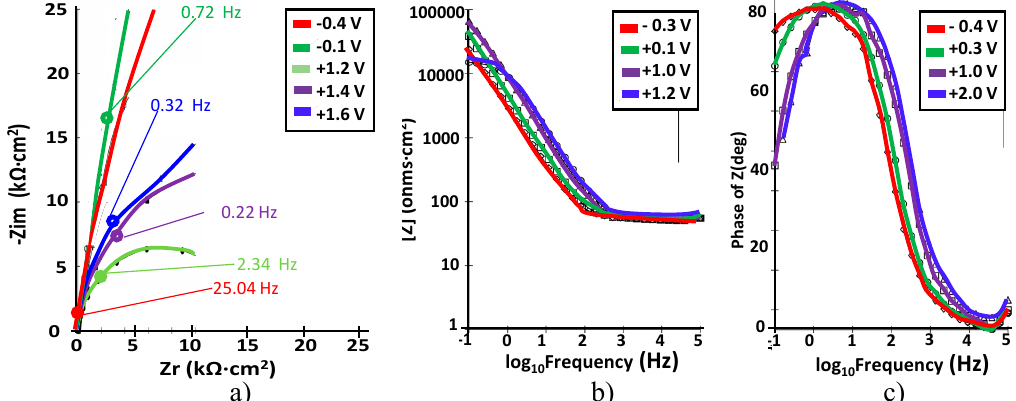
Figure 8. ( a ) Nyquist; ( b ) Bode –IZI and ( c ) Bode-phase spectra at different potentials for Ti–25Ta in simulated body fluid at pH = 7.8.